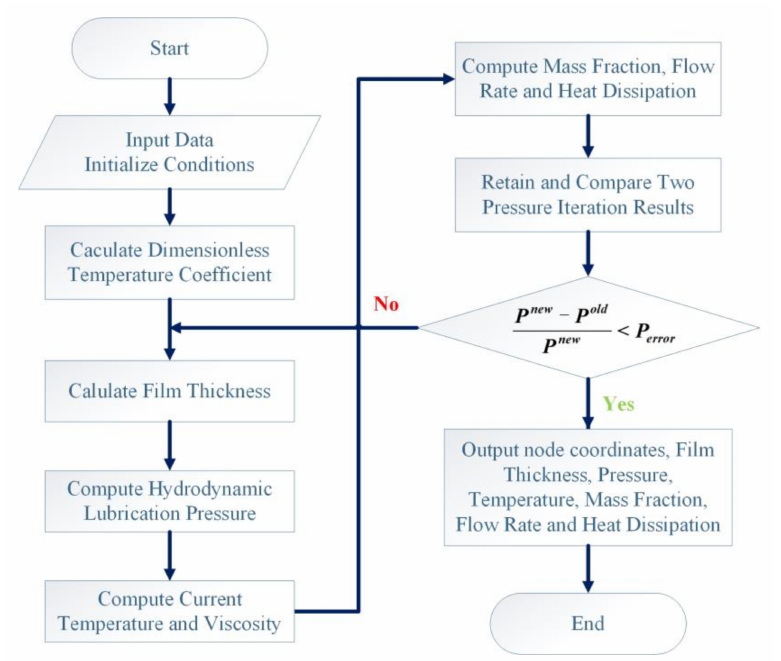
Figure 3. Calculation iterative